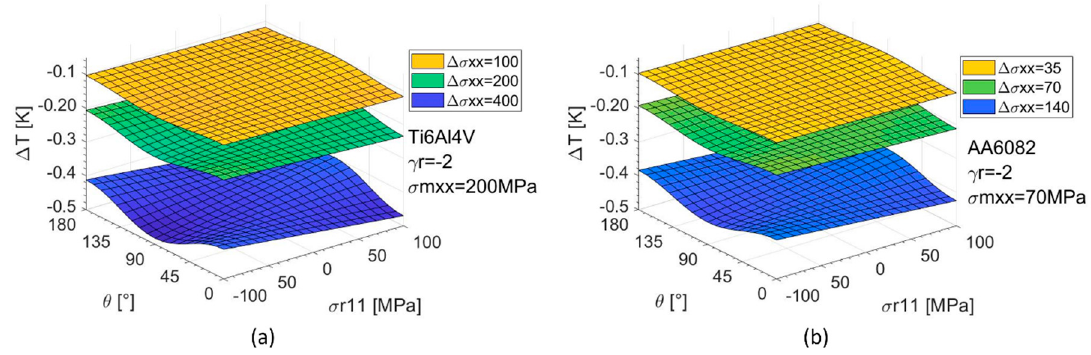
Figure 5. Effect of the load amplitude on temperature variations for AA6082 ( a ) and Ti6Al4V ( b ) alloys.